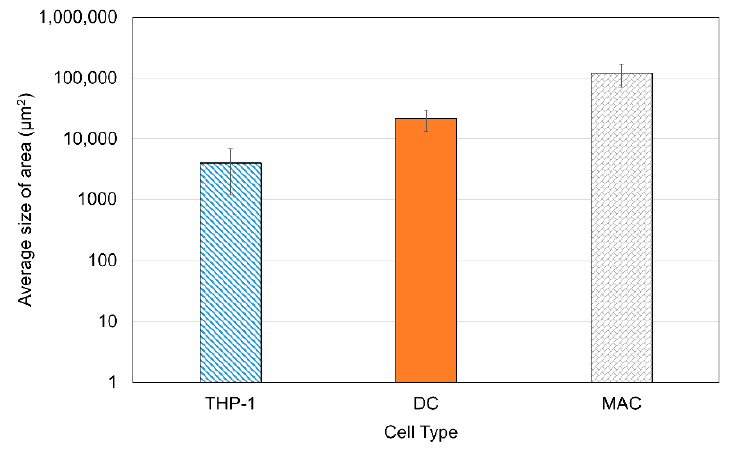
Figure 5. The calculated average area of each cell with S.E.M bars. MACs have the largest area, followed by DCs, and finally THP1 cells.